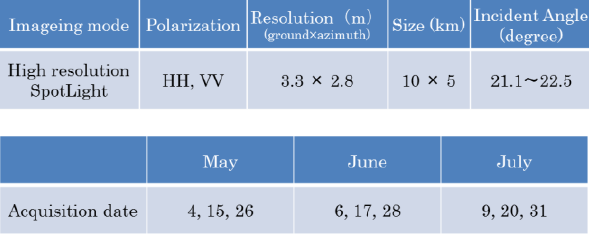
Table 1. Imaging mode of TerraSAR-X and acquisition dates